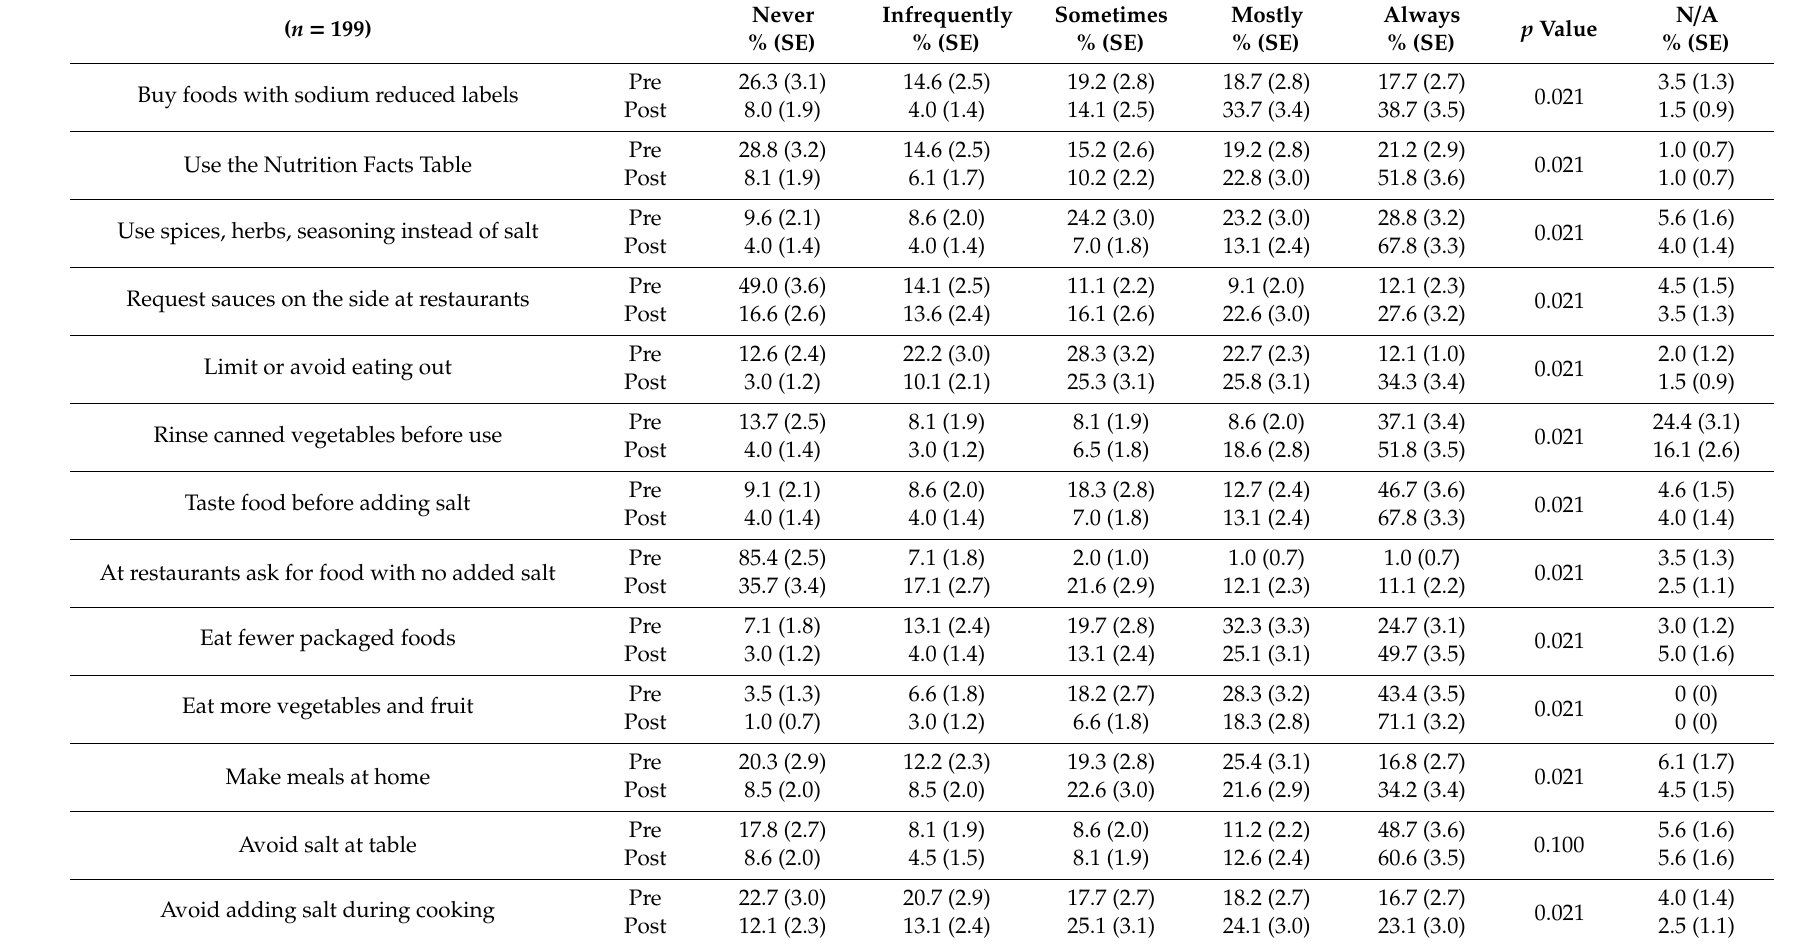
Table 2. Engagement in intended behaviours to reduce dietary sodium before and after using the sodium calculators. ( n =